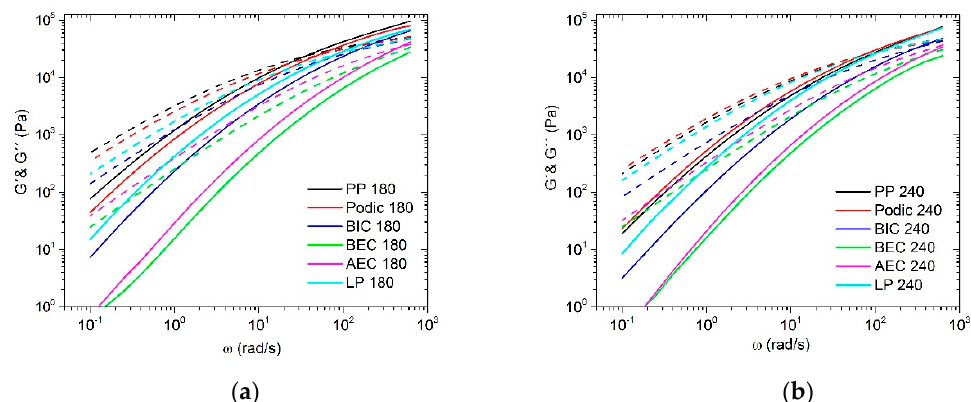
Figure 5. Storage and loss moduli as a function of angular frequency of samples extruded at ( a ) 180 °C; ( b ) 240 °C; measured at 230 °C. ( b ) 240 ◦ C; measured at 230 ◦ C.